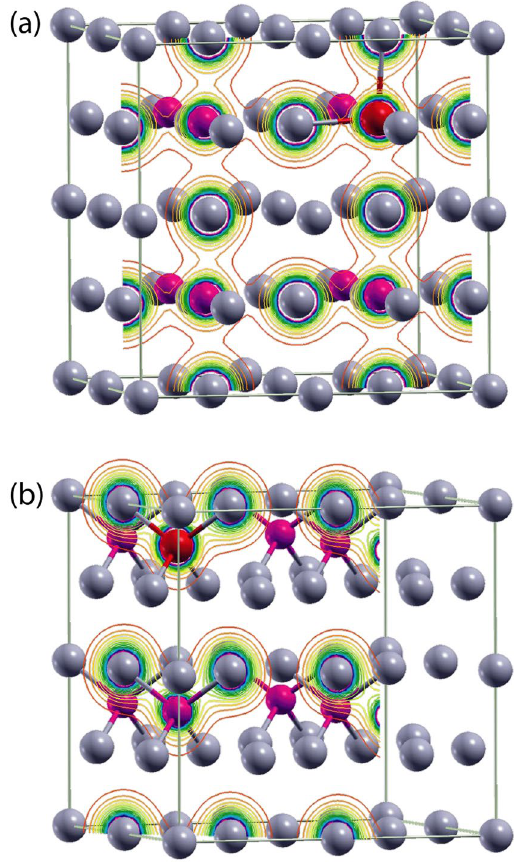
Figure 5. Local structure around Fe Ge in a 2 × 2 × 2 supercell of GeTe in ( a ) the rhombohedral structure of c-GeTe and in ( b ) a-GeTe, where local configuration around Fe Ge is assumed tetrahedral. Red spheres indicate the Fe impurity substituting Ge (purple spheres) in the two configurations, where grey spheres represent the Te